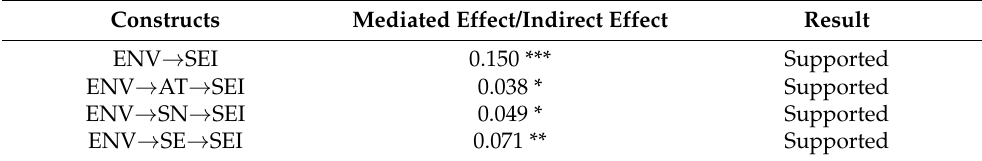
Table 3. Results of the mediating analysis among the constructs and proposed